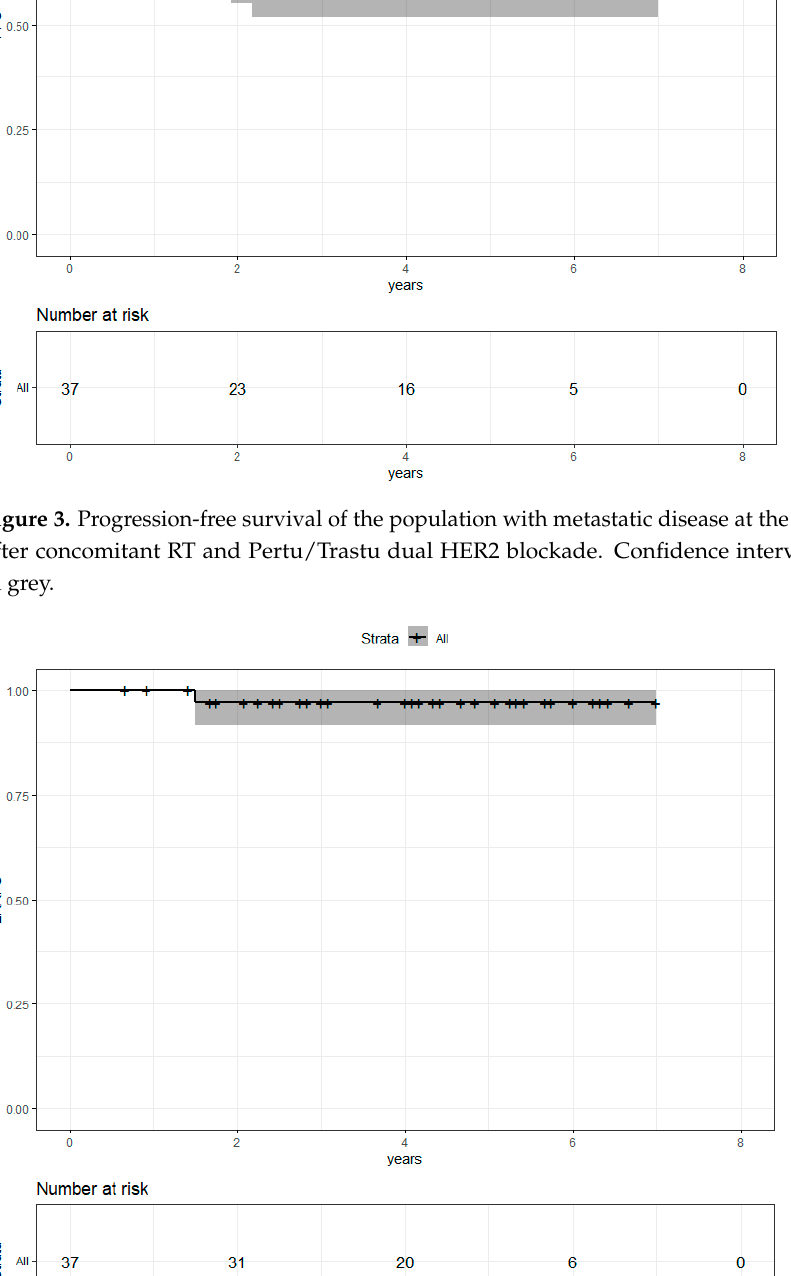
Figure 4. Locoregional recurrence-free survival in the population with metastatic disease at the time of diagnosis after concomitant RT and Pertu/Trastu dual HER2 blockade. Confidence intervals are provided in grey.